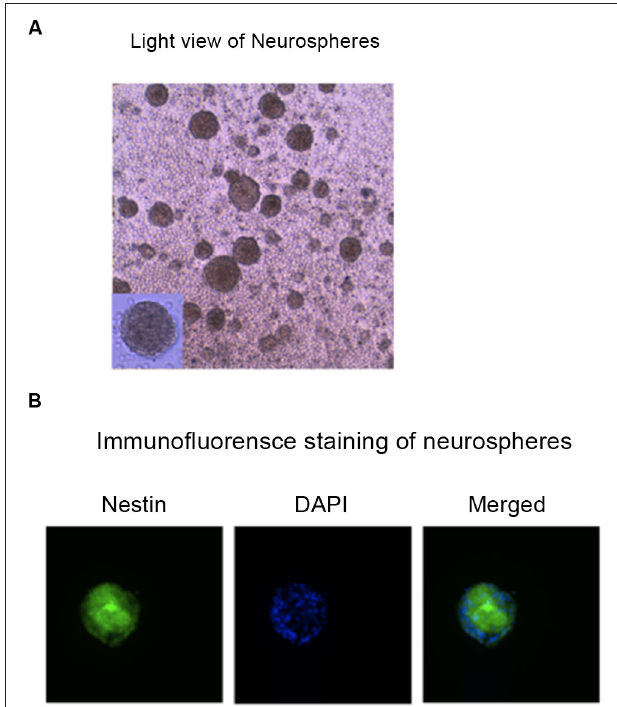
FIGURE 1 | Identification of the mouse NPCs. Photomicrographs of hippocampus NPCs grown in the “complete” proliferation culture media. (A) Phase contrast photograph taken before fixation of a floating neurosphere grown in a six-well plate. (B) Immunofluorescence image of a neurosphere that was fixed and expressed nestin (the marker of NPCs, green), DAPI (the marker of nuclei, blue), and merged image of a neurosphere plated on FluoroDish. NPCs, neural progenitor cells; DAPI, 4’, 6-Diamidino-2-Phenylindole,